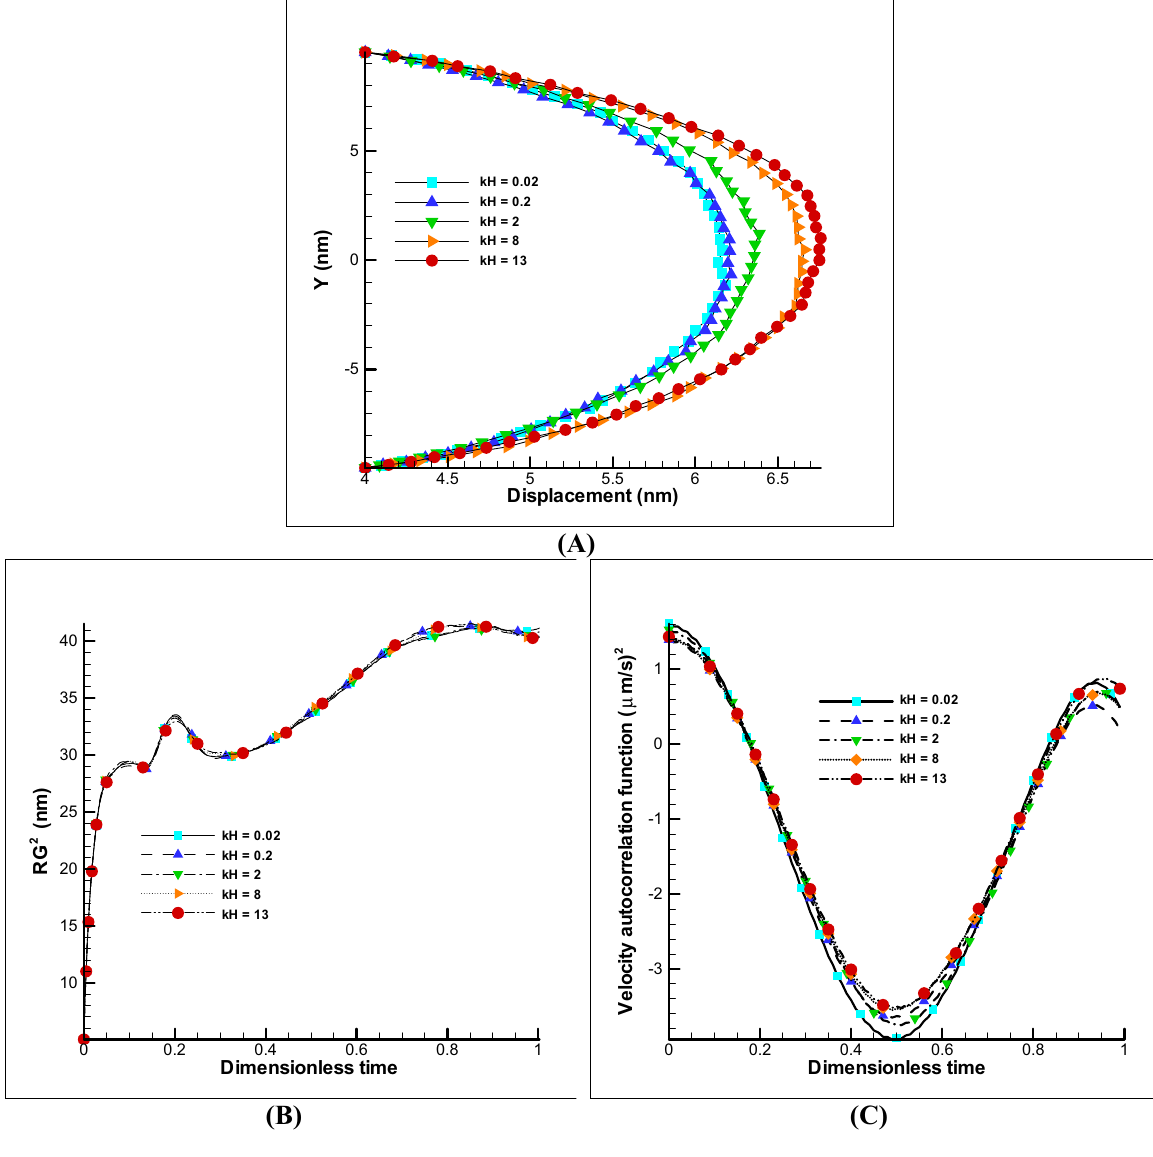
Figure 4. Changes of kH parameter on EOF with E0 = 250 V/m and Ψ 0 = − 25 mV and impermeable polymer membrane displacement. Different displacement of polymer membrane by changing kH parameter ( A ). Variation of radius of gyration and VACF over dimensionless time (t/t max ) by changing the kH parameter ( B , C